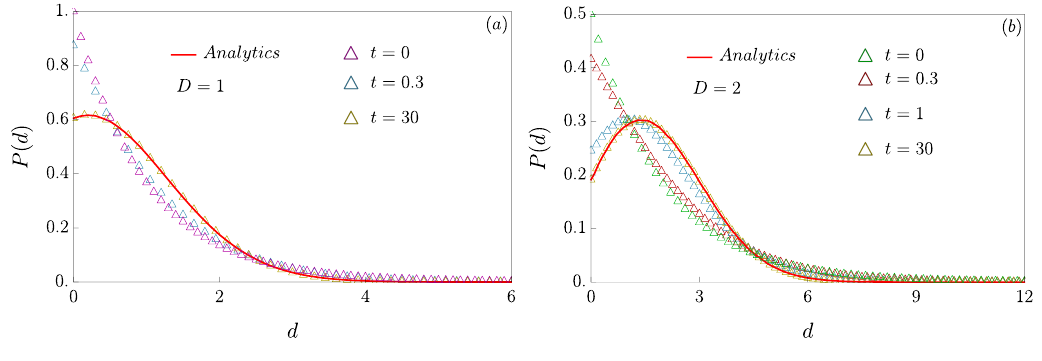
Figure 7: (a) Comparison between time evolution of rescaled density moments ω = 〈| φ | 2 K 〉 / [( 〈| φ | 2 〉 ) K K ! ] computed from the direct simulation of the NLS and K steady state values predicted from Eq. (39) (red dashed lines). The initial state in chosen as in Fig.6 and we focus on the D = 2 case. Since the initial state is gaussian, = 1, however as time passes the strongly interacting nature at time t = 0 we have ω K of the system is unveiled and the values of ω depart from unity, relaxing to the pre- K dicted asymptotic value with excellent accuracy. In our microscopic simulation we experienced important finite-size effects and the data shown in the plot are extrap- olated to the thermodynamic limit. (b) We provide a brief analysis of the finite-size effects focusing on the time evolution of the first non trivial observable ω . Inset: 2 extrapolation to the thermodynamic limit of the plateau extracted from the micro- scopic evolution (blue line) and of the plateau obtained from the root density (yellow line). In both cases, we observe a clear ∝ L − 1 approach to the asymptotic values, which are in perfect agreement.